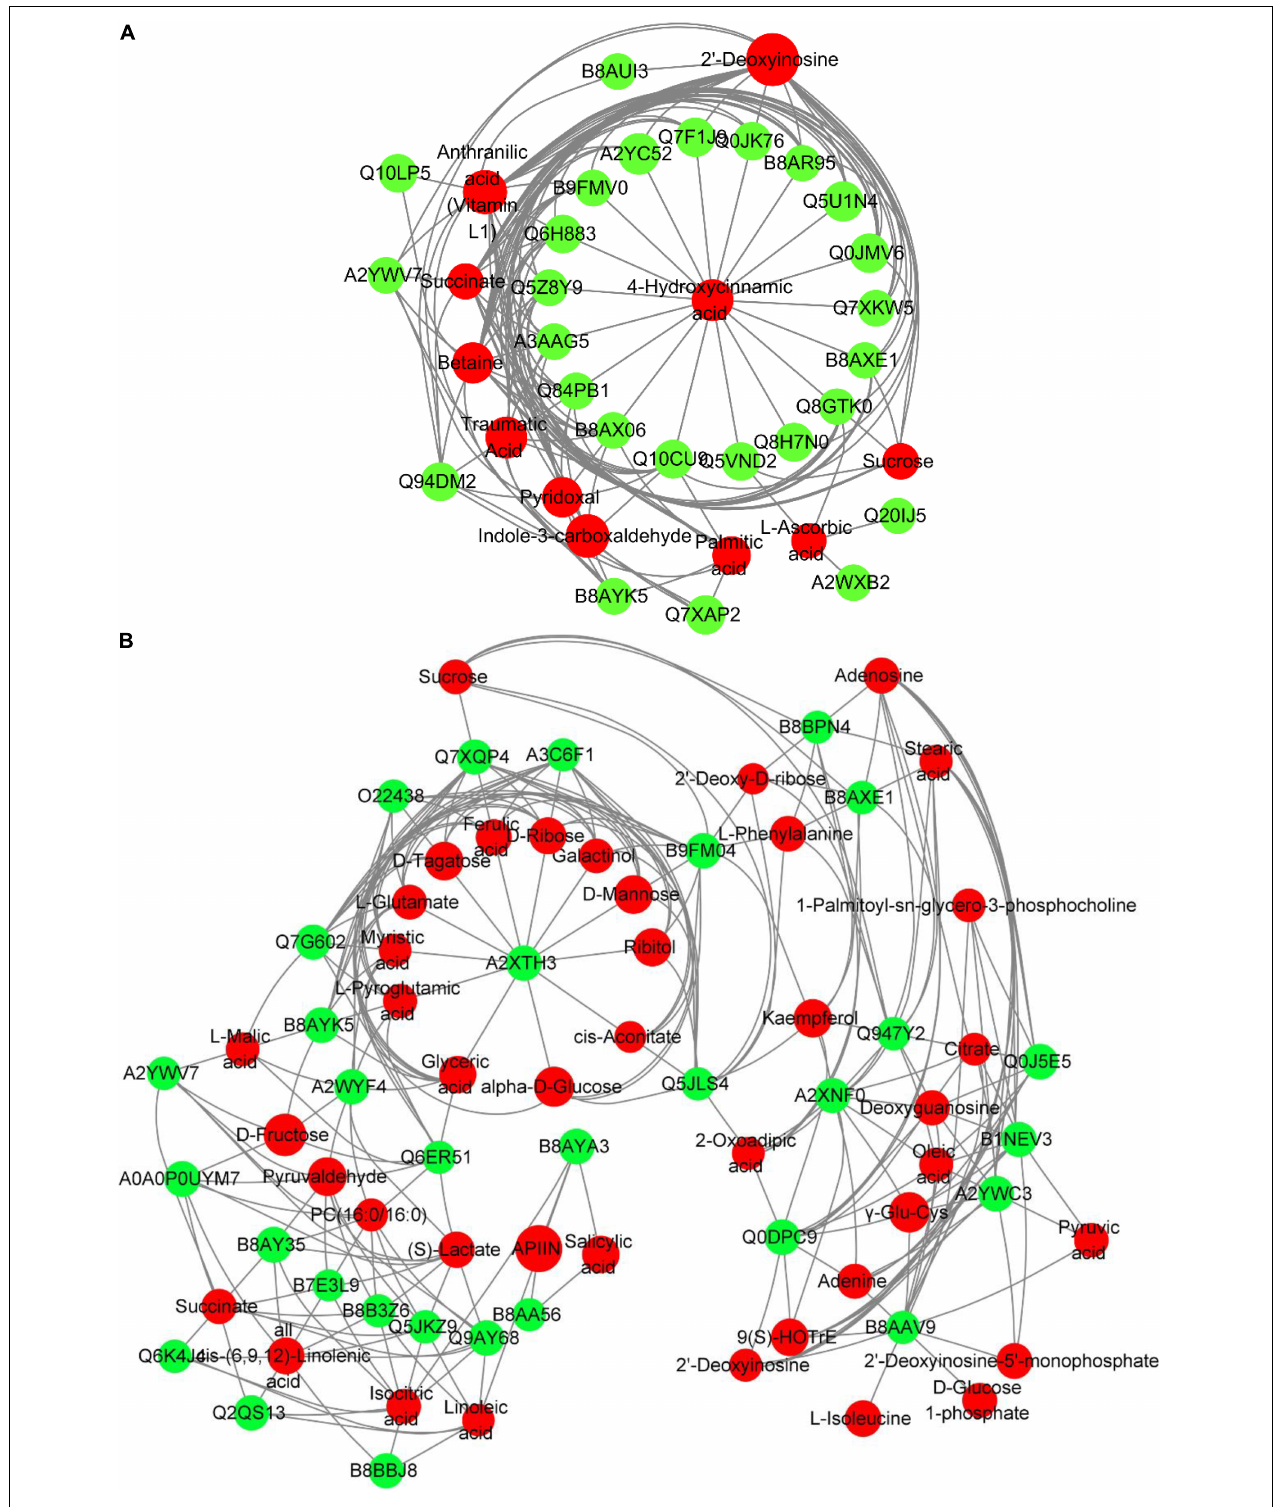
FIGURE 8 | Network analysis of the mutual regulation relationship between different proteins and different metabolites in the same KEGG pathway. Red indicates differential metabolites, and green indicates DAPs. The size of the dots represents the difference multiples of different metabolites and DAPs. The greater the difference multiples, the larger the dots. (A) three-leaf stage; (B) tillering stage.